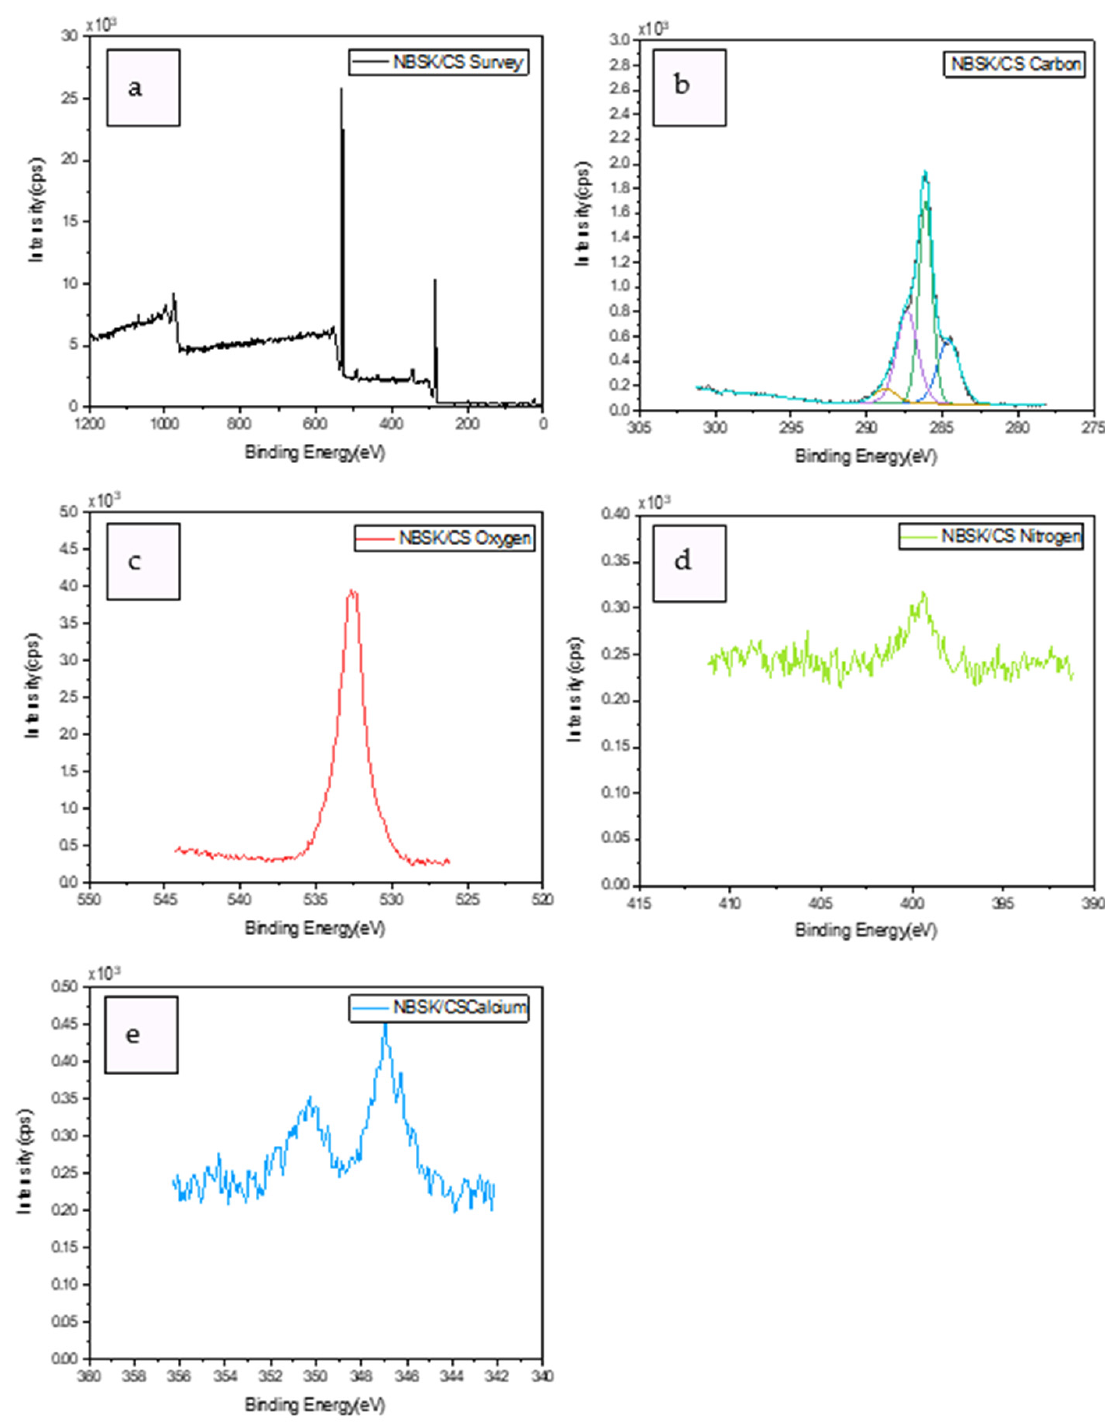
Figure 6. XPS Spectra for NBSK/CS 70:30: ( a ) full field survey, ( b ) carbon, ( c ) oxygen, ( d ) nitrogen, and ( e ) calcium.